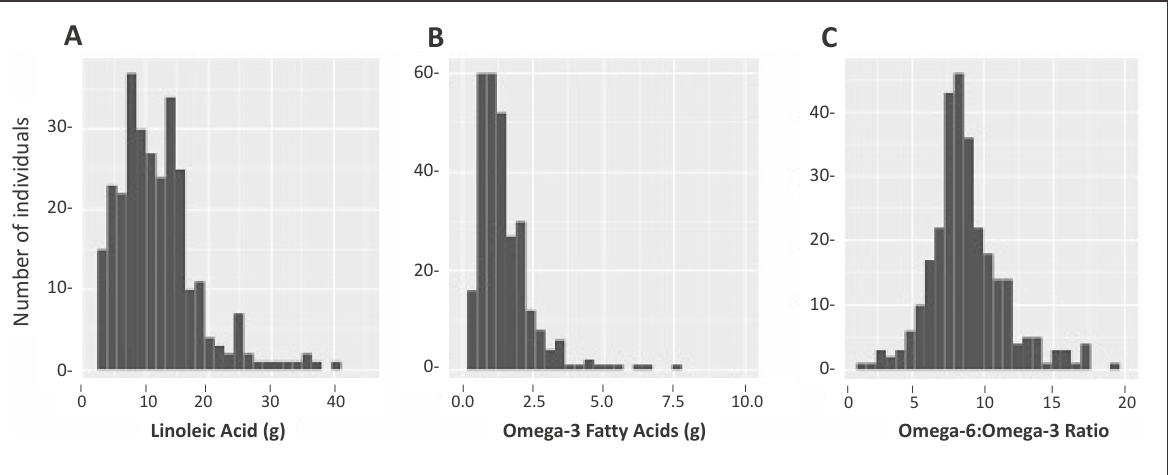
Figure 2. Intake distribution of linoleic acid (g), omega-3 fatty acids, (g) and Omega-6 to Omega-3 ratio in a Mexican-origin Hispanic sample from Southern Arizona (N = 285). ( A ) Distribution of Omega-6 (predominantly Linoleic Acid); ( B ) Distribution of Omega-3 ( α -Linolenic Acid, Eicosapentaenoic Acid, Docosapentaenoic Acid, and Docosahexaenoic Acid); ( C ) Distribution of Omega-6 to Omega-3 ratio. Note the difference in the scales for both axes.